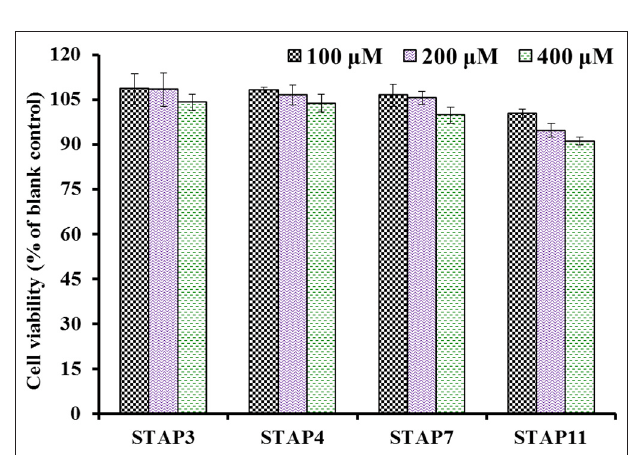
FIGURE 6 | The cell viability of HUVECs treated with STAP3, STAP4, STAP7, and STAP11 for 24h at 100, 200, and 400 µ M, respectively.